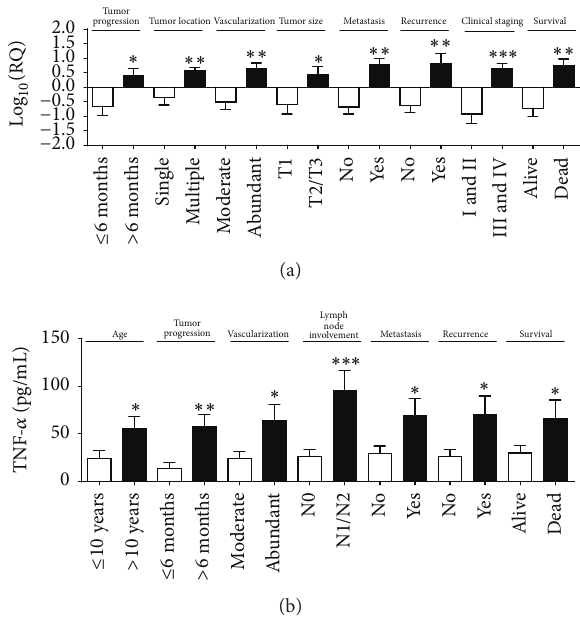
Figure 6: TNF- 𝛼 gene overexpression correlated with (a) tumor progression for more than 6 months; multiple tumor locations; abundant tumor vascularization; tumor mass size greater than 3 cm; metastasis; recurrence; clinical staging III or IV; and animals that died. Higher TNF- 𝛼 protein levels correlated with (b) age > 10 years; tumor progression for more than 6 months; abundant tumor vascularization; lymph node involvement; metastasis; recurrence; and animals that died ( 𝑝 = 0.04 ). Error bars ± standard error; ∗ 𝑝 < 0.05 ; ∗∗ 𝑝 < 0.01 ; ∗∗∗ 𝑝 < 0.001 indicate significant differences according to Student’s 𝑡